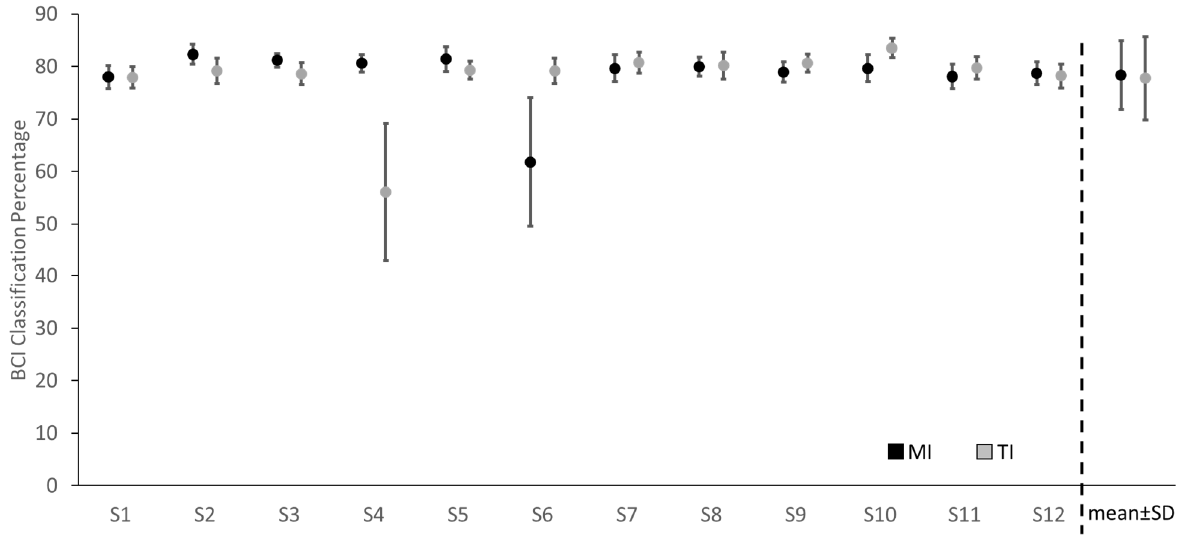
Figure 5. Classi fi cation percentage for each subject and the mean classi fi cation percentage. Figure 5. Classification percentage for each subject and the mean classification